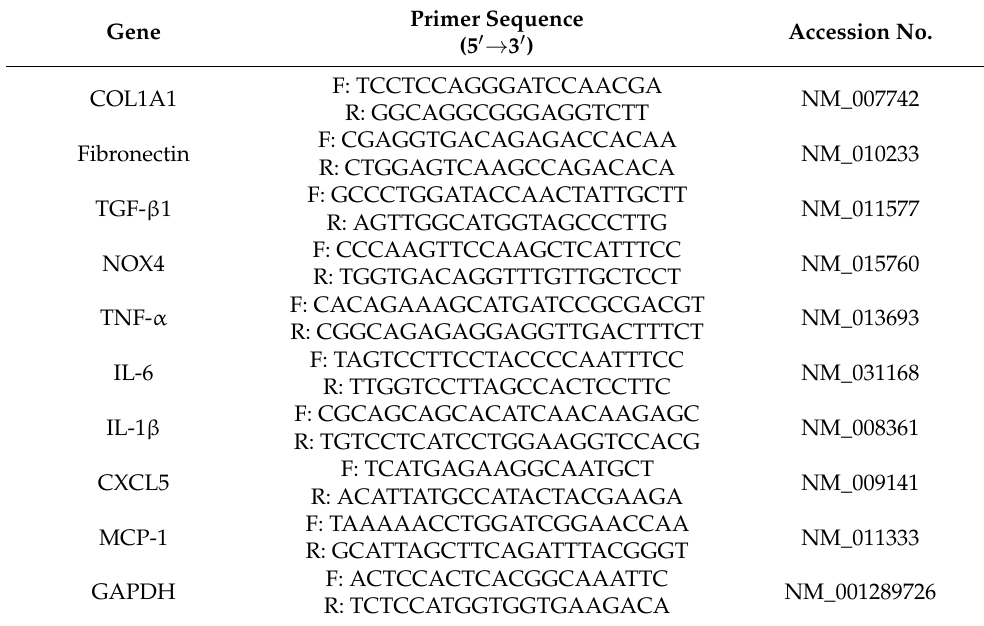
Table 1. List of